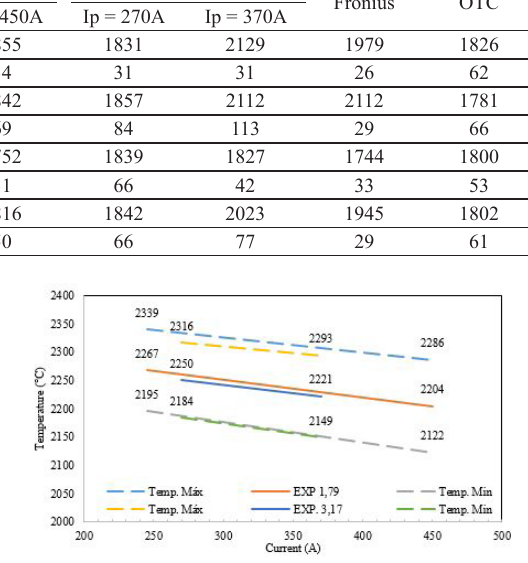
Figure 7. Droplet temperature versus Pulse current.